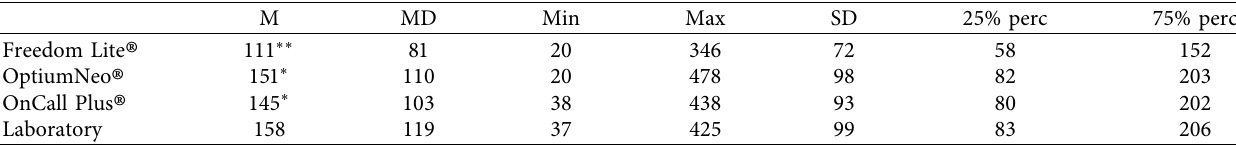
Table 2: Descriptive and comparative statistics of blood glucose concentration in diferent glucometers and the reference method in dogs from Brazil.